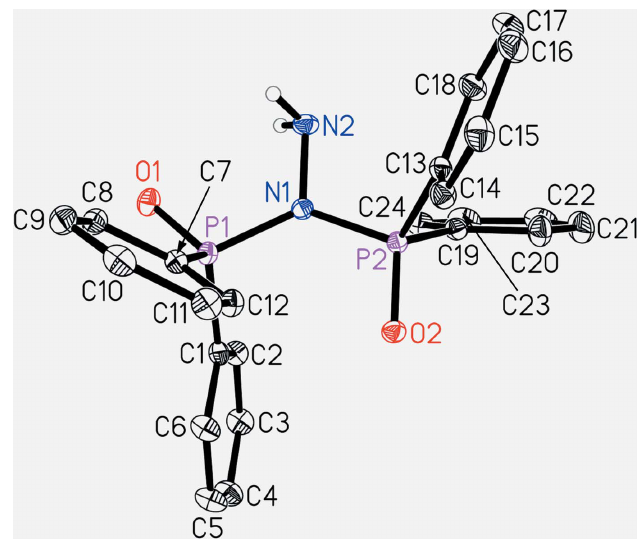
Figure 1 The molecular structure of the title compound, with displacement ellipsoids drawn at the 30% probability level. Aromatic H atoms have been omitted for clarity.